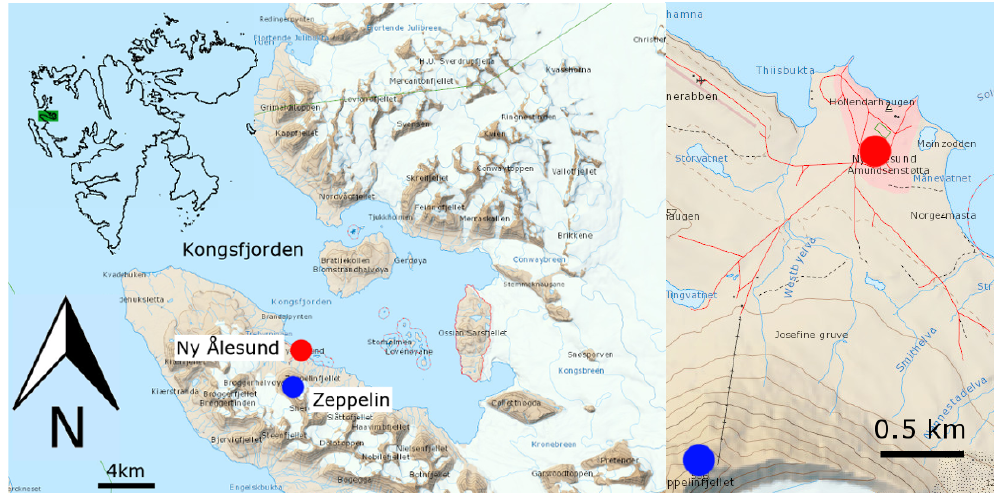
Fig. 1. Left panel: map of the Kongsfjord area of Svalbard, showing the locations of the village of Ny Ålesund (red dot) and the Zeppelin Mountain station (blue dot). The inset in the upper left corner shows the coastlines of Svalbard, the green rectangle indicating the approximate extent of the map. Right panel: detailed map of the Ny Ålesund area, with the red dot showing the position of the Ny Ålesund monitoring station, and the blue dot showing the position of the Zeppelin Mountain station. (Courtesy of Norwegian Polar Institute, http://toposvalbard.